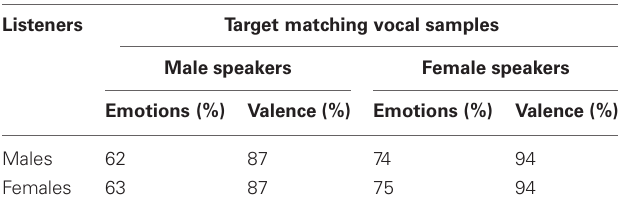
Table 9 | Results of the emotionally loaded samples identified in percentages by gender of speakers and